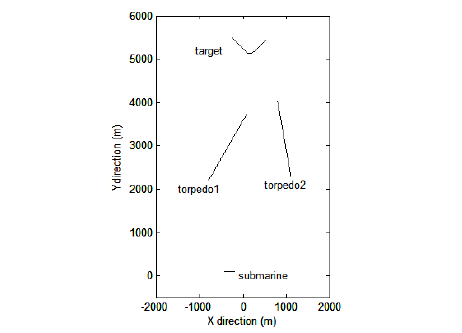
Fig. 2. Moving trajectories.